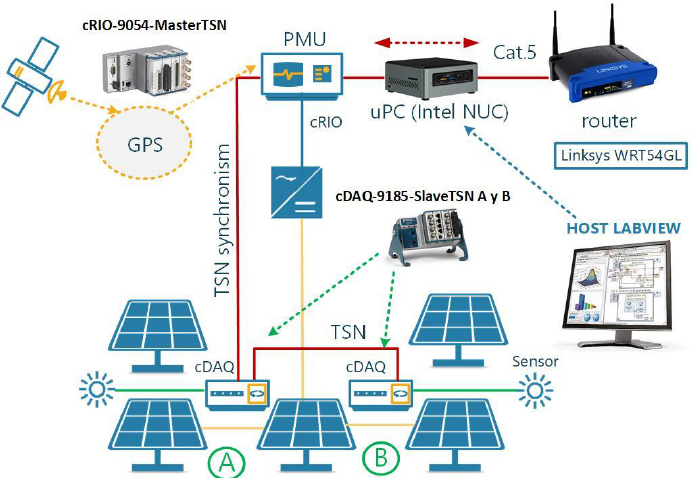
Figure 2. Configuration (1) for tests with one cRIO-9054 and two cDAQ-9185s at a close range.